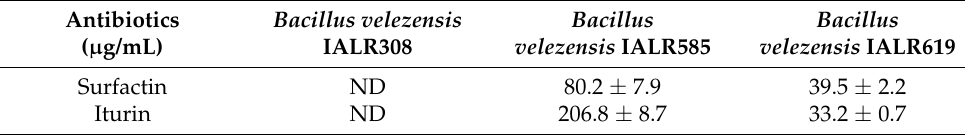
Table 5. Surfactin and iturin production in cultures of bacterial endophytes.